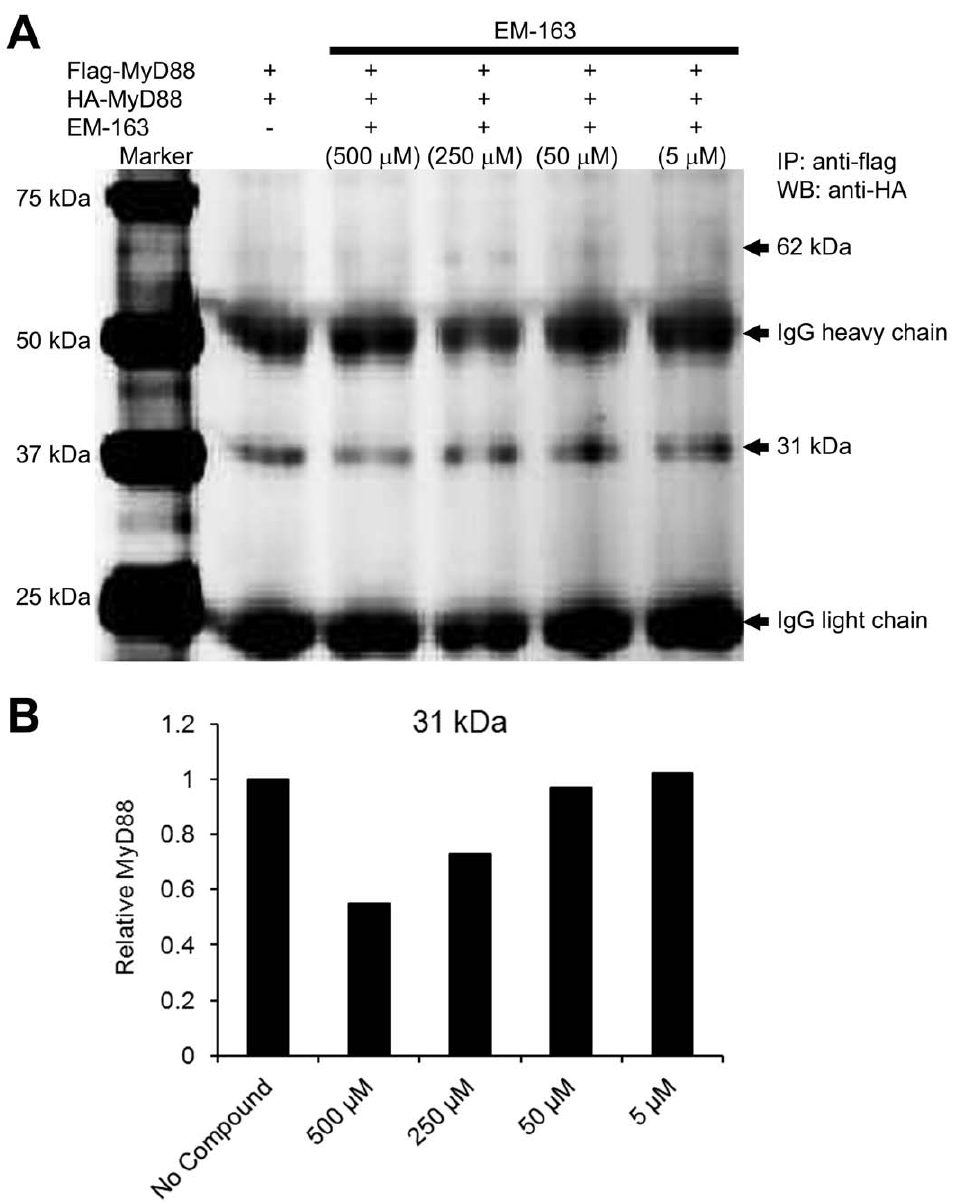
Figure 5. EM-163 targets newly expressed MyD88 and stabilizes the MyD88 complex. HEK 293T cells were co-transfected with plasmids MyD88- Flag or pCMV-HA-MyD88. Seven hours after transfection, cells were incubated for 13 h with or without 2 163 (500 m M to 5 m M). ( A ), Cell extracts were immunoprecipitated (IP) with anti-Flag antibody, and immune-precipitated proteins were analyzed in Western blot with anti-HA. ( B ) Densitometry analysis of the results shown in ( A ). The results are representative of three independent